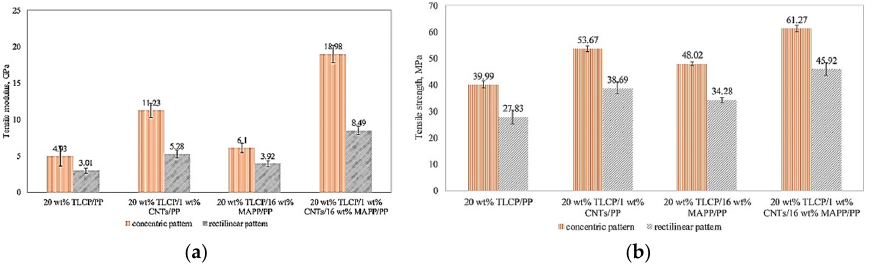
Figure 7. ( a ) Tensile modulus and ( b ) Tensile strength of laid down specimens printed in concentric and +45° rectilinear printing patterns. With permission [28]. and +45 ◦ rectilinear printing patterns. With permission